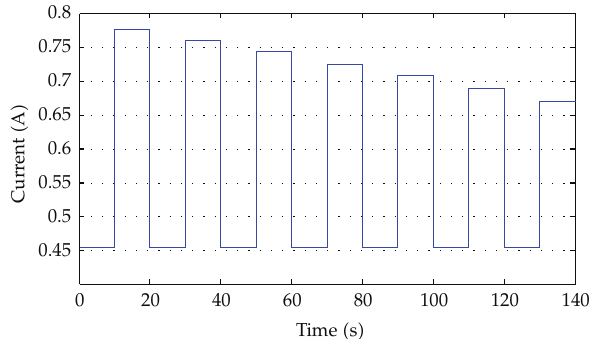
Figure 17: The decaying step current applied in the first validation process.